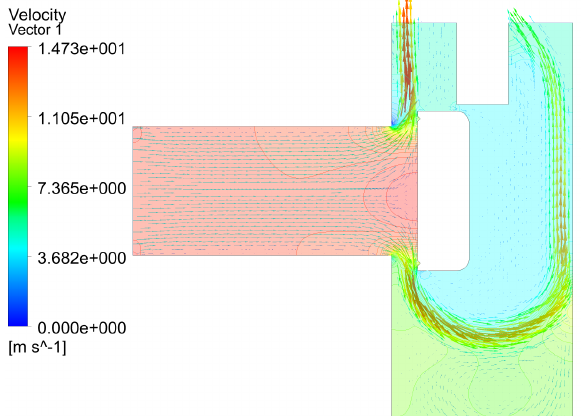
Figure 7: Negative flow condition reveal two VC which almost do not interfere with the